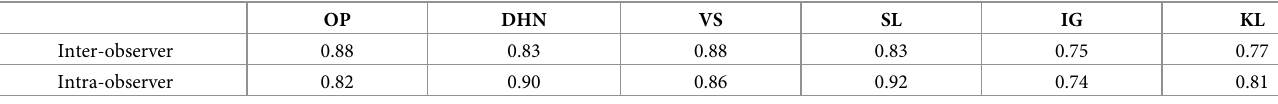
The inter-and intra-observer reproducibility in each radiographic feature was shown by the kappa coefficient. OP: osteophyte, DHN: disc height narrowing,